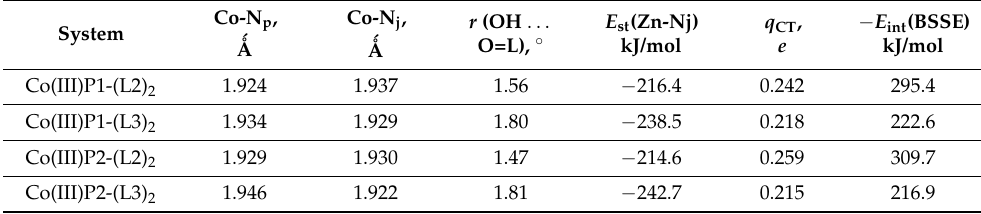
Table 2. Geometrical and energetic parameters of